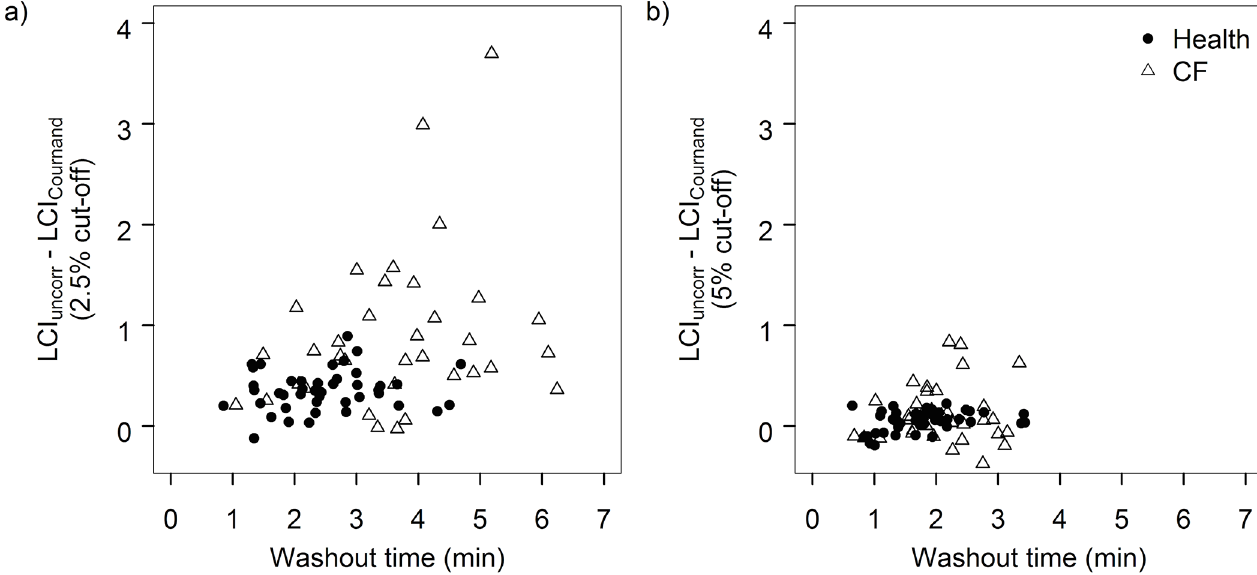
Fig 6. Relationship between the contribution of tissue N 2 to LCI N2 and length of washout calculated at a) the traditional 2.5% washout cut-off and b) the 5% washout cut-off . The contribution of tissue N 2 to LCI N2 calculatedat the 2.5% cut-off (LCI uncorr − LCI Cournand ) increasedas washout time increased. However, this relationshipwas no longerobservedat the earlier5% cut-off.